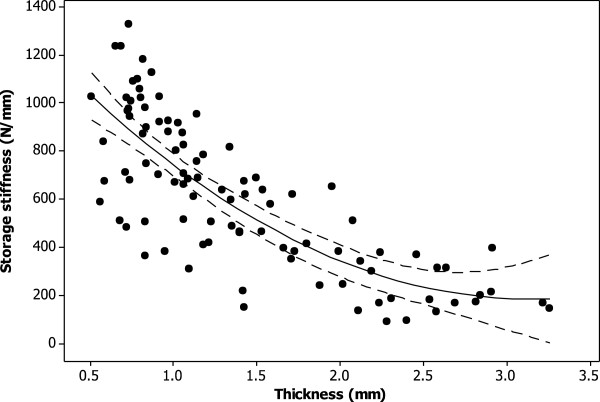
Thickness dependent storage stiffness of knee joint cartilage at 1 Hz. A second order polynomial curve (see equation 3) was fitted to the experimental data (R2 = 63%; p < 0.05) as shown (solid line). The 95% confidence intervals are also included (dashed line).